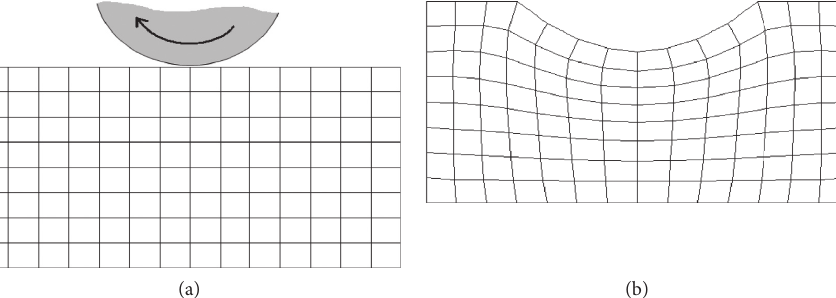
Figure 6: Boundary displacement technique for geometry update schemes in the FEM approach. (a) Initial geometry. (b) Updated